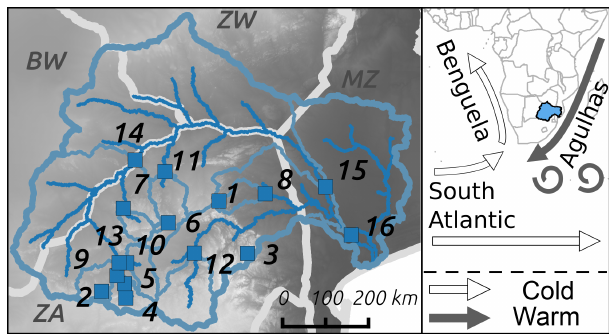
Figure 1. Location of the Limpopo Basin and streamflow stations. Streamflow stations with sub-basins are numbered according to Ta- ble 1 and elevation (max. 2300m) as background (left). Location of the Limpopo Basin within sub-Saharan Africa and schematic of ocean currents with the warm Agulhas Current and the Benguela, South Atlantic and Antarctic Circumpolar (South Atlantic) currents shown on the right.